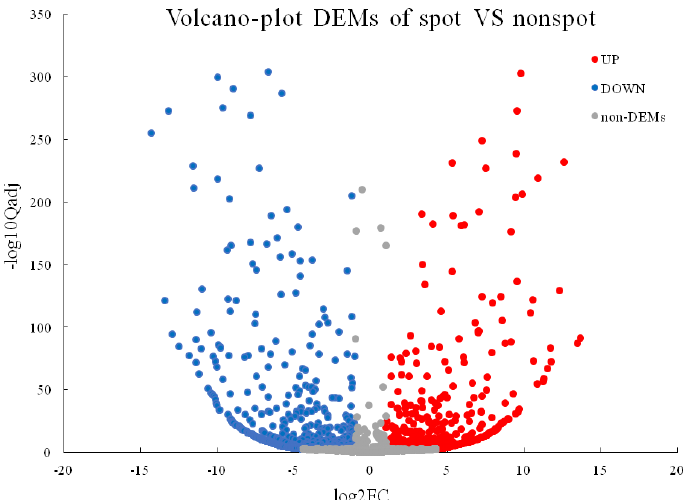
Figure 5. Volcano plot of DEMs. X axis represents log2 transformed fold change. Y axis represents − log10 transformed significance. Red points represent upregulated DEMs. Blue points represent downregulated DEMs. Gray points represent non-DEMs. Table 3. Putative miRNAs targeting on MYB , bHLH or WRKY unigenes.